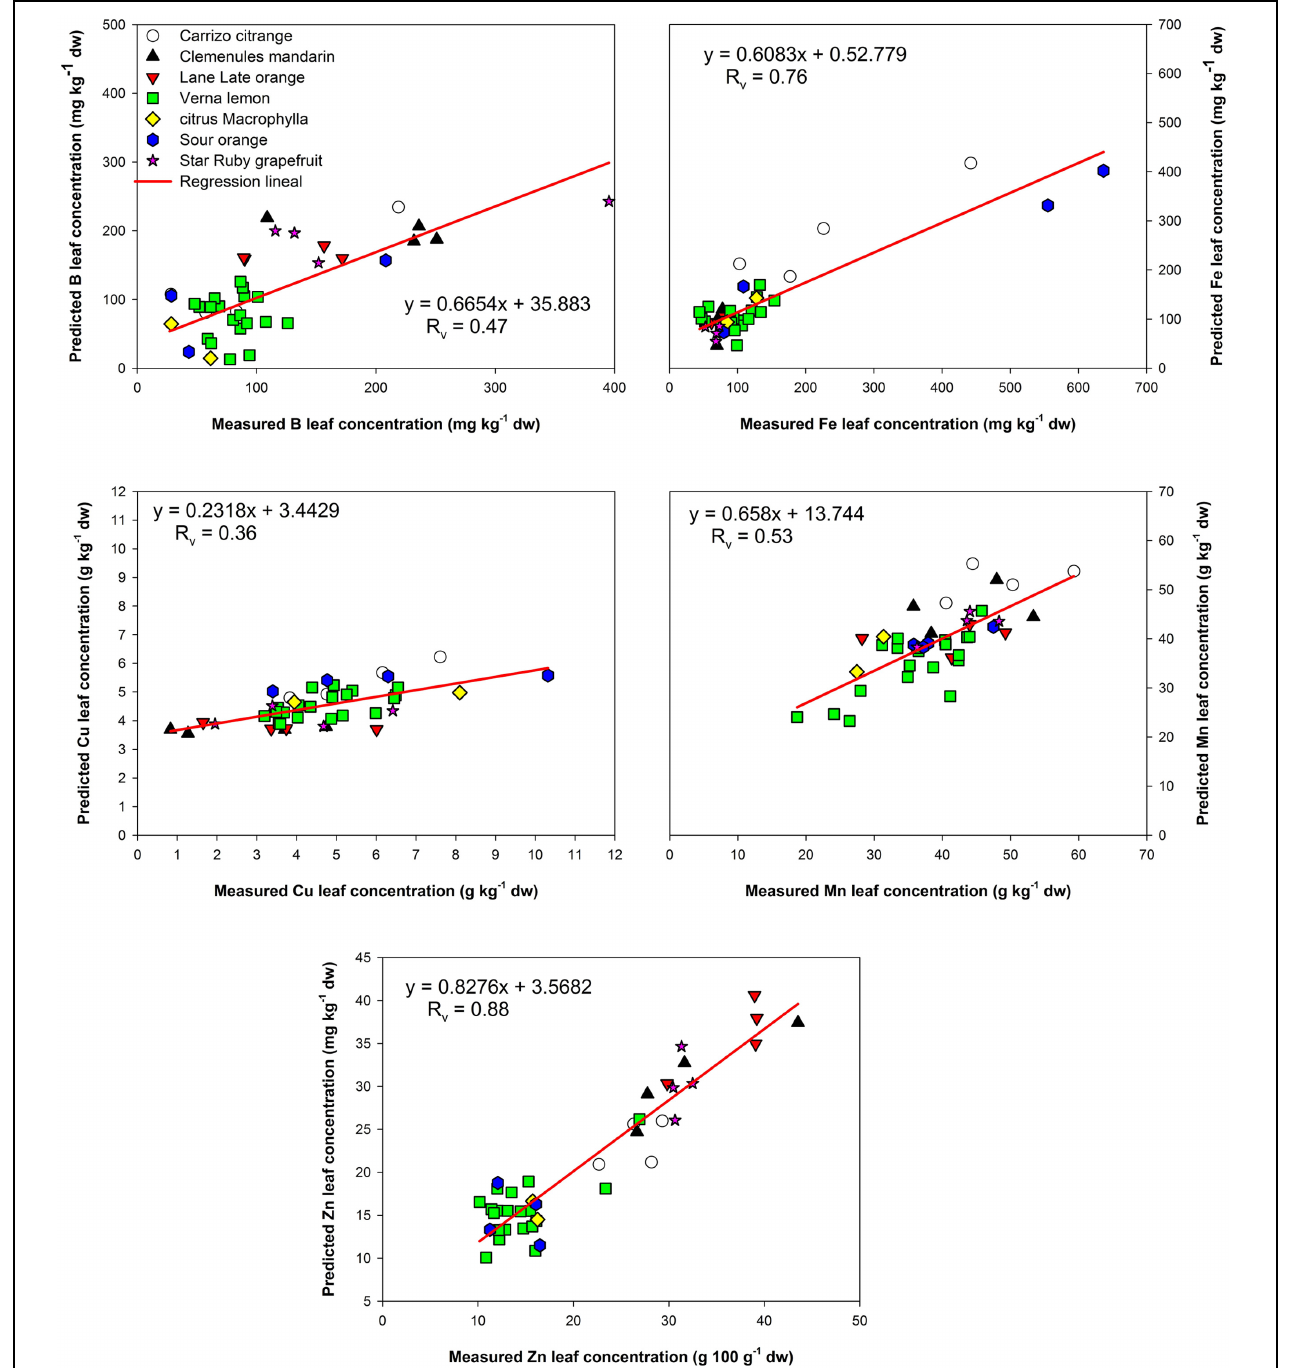
FIGURE 3 | Near infrared reflectance spectroscopy validation plots between predicted and real (measured) values for B, Fe, Cu, Mn, and